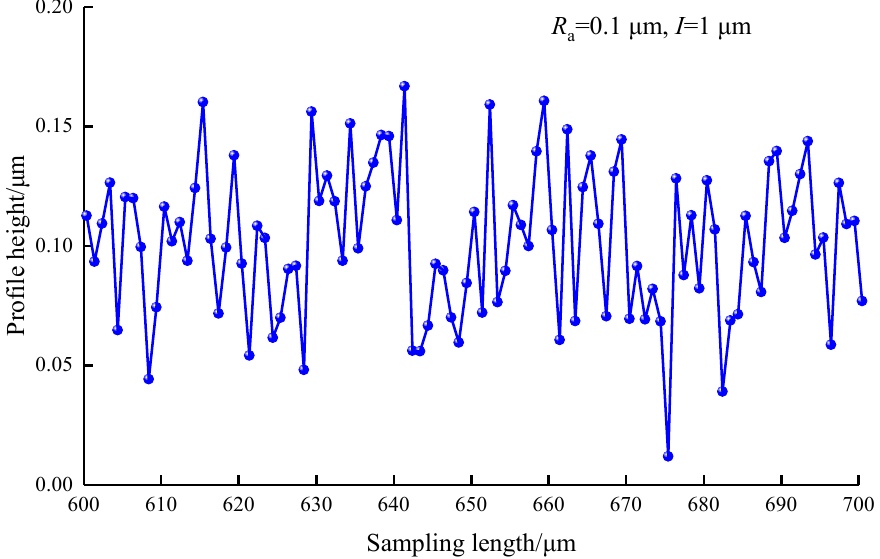
Figure 3. Local magnification of simulated profile curve of rough surface.